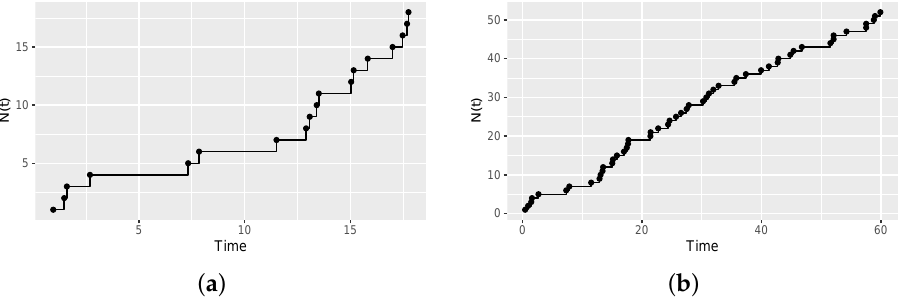
Figure 2. Simulation of a Cox process with Folded Normal intensity with parameters µ = 0, σ 2 = 9 and with covariance function k Z ( h ) = 9 e −| h | for T = 20 ( a ) and T = 60 ( b ).